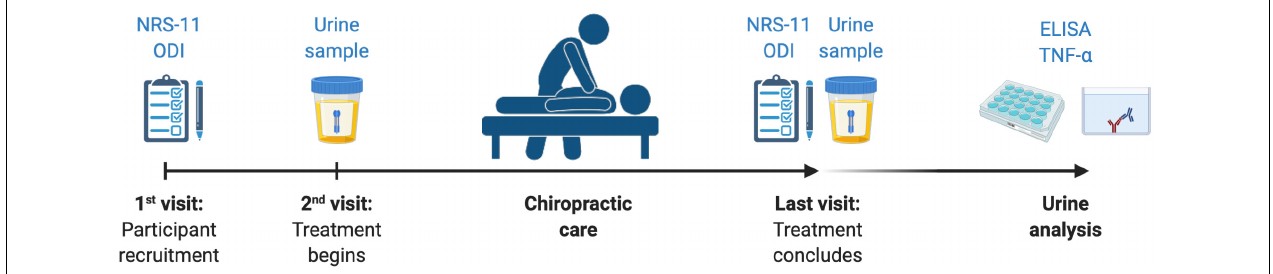
FIGURE 1 | The study protocol, including outcomes measures collected in relationship to treatment period. NRS-11, Numerical Rating Scale 11; ODI, Oswestry Disability Index; TNF- α , Tumor Necrosis Factor-alpha.